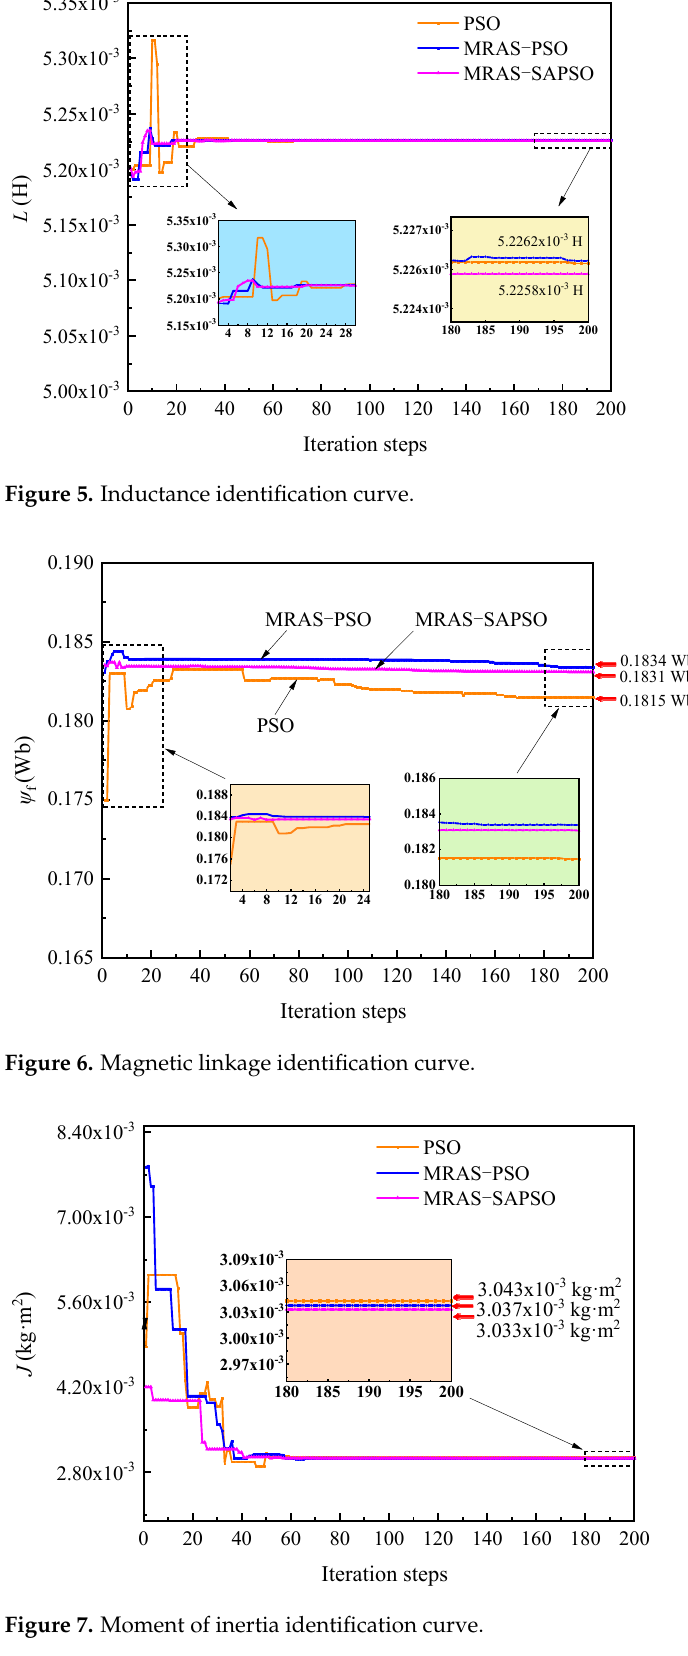
Figure 7. Moment of inertia identification curve.